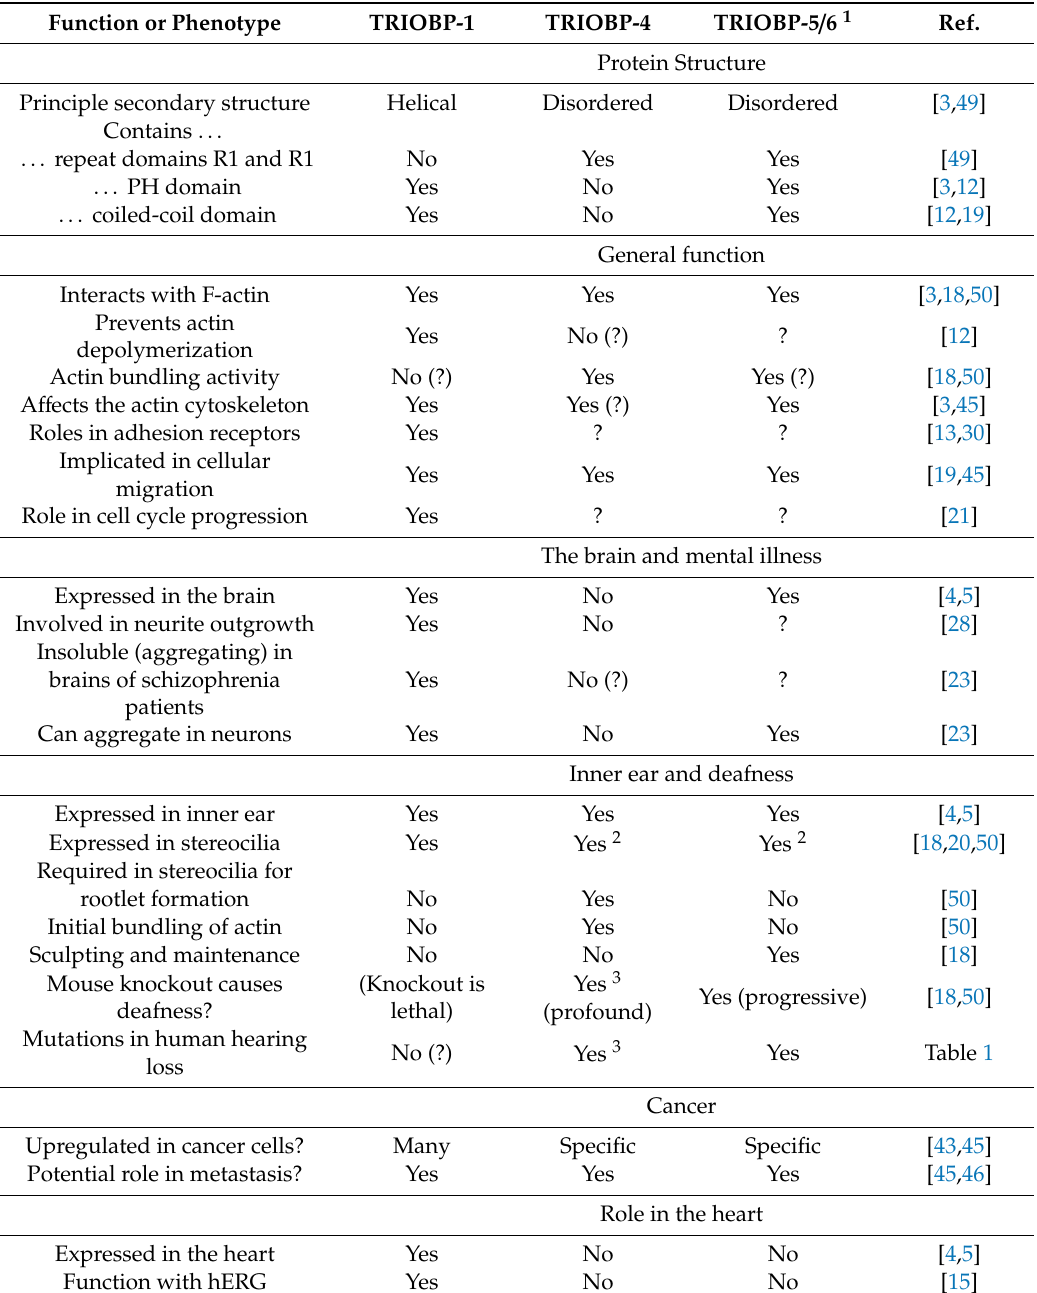
Table 2. Normal functions and disease states associated with the TRIOBP